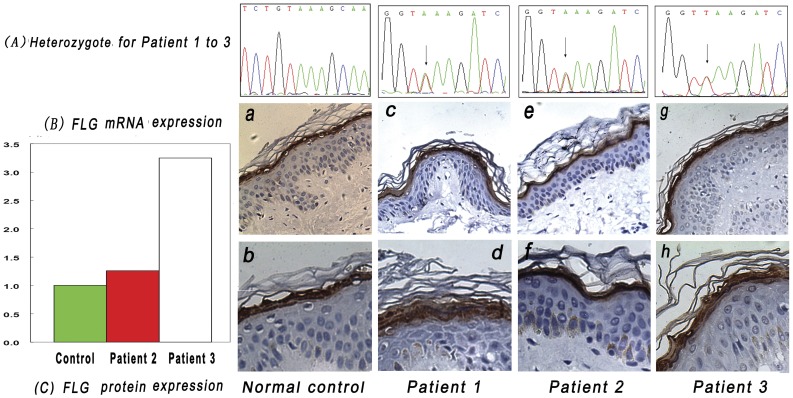
Filaggrin gene mutation analysis and comparison of filaggrin expression.The normal control was an FLG
wt male adult. Patient 1 and 2 with K4671Xheter variant were mothers of 2 atopic dermatitis (AD) patients. Patient 3 was an adult male AD patient with K4671Xheter variant. Skin with normal appearance was got from the 4 subjects. (A) Identification of FLG mutations in 3 patients. Patient 1, 2, and 3 were all heterozygote for K4671X. (B) Quantitative Real-time reverse transcription–polymerase chain reaction analysis of FLG mRNA expression in the skin of normal control and 2 patients with K4671Xheter variant. Direct sequence analysis of FLG cDNA from mRNA expressed in skin samples further confirmed that Patient 2 and 3 were heterozygote for K4671X. FLG mRNA expression was not reduced either in Patient 2 or 3: FLG mRNA expression in Patient 2/3: FLG mRNA expression in control was1.26 and 3.25, respectively. (C) Immunohistochemical staining using antifilaggrin monoclonal antibody in 4 subjects at the same time (a,c,e,g,i: Original magnification×100; b,d,f,h,j:Original magnification×200). Immunohistochemically, it was obvious that filaggrin was strongly positive in the epidermis of Patient 1, 2, and 3(c–h).